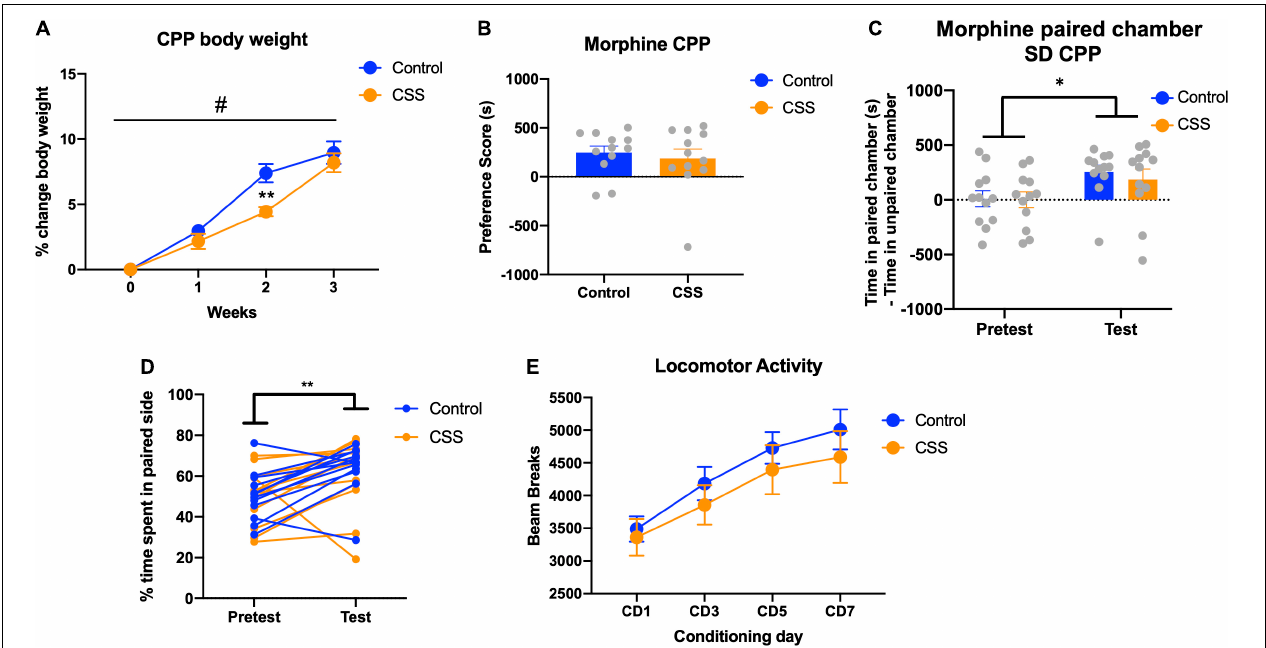
FIGURE 5 | (A) Body weight for the animals in the CPP cohort during the 4 weeks of sleep deprivation. ** indicates p < 0.01. (B) Preference score for CPP, defined by time in the morphine-paired chamber on the post-conditioning test day of CPP minus time in the morphine-paired chamber on the pretest. (C) Time in the morphine paired chamber minus time in the saline paired chamber, for both pretest and test. (D) % of time spent on the morphine-paired side of the CPP chamber on both the pretest and posttest, repeated measures by animal. (E) Locomotor activity from the 4 days of conditioning with morphine. * indicates p < 0.05, # indicates significant main week × CSS interaction